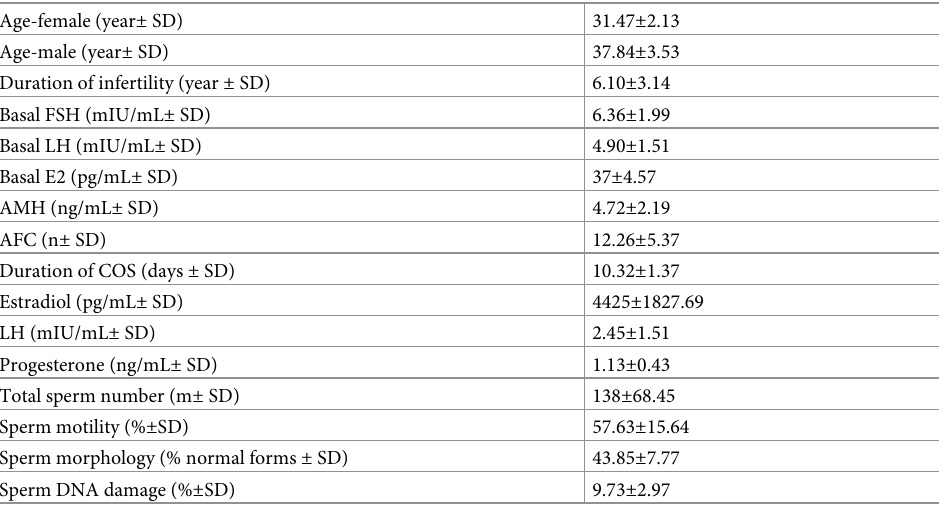
Table 1. Patient’s demographics and clinical